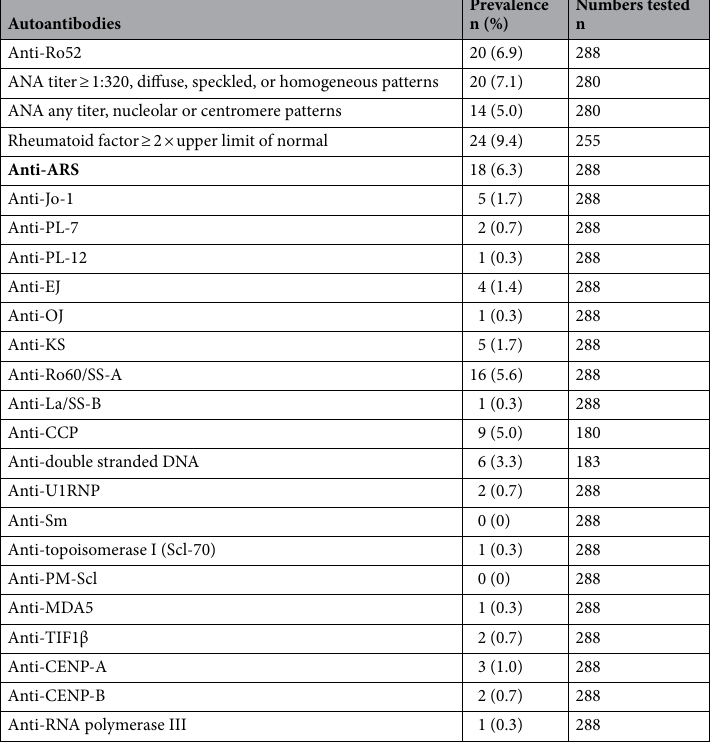
Table 1. Prevalence of autoantibodies in idiopathic interstitial pneumonitis (IIP) patients. Data presented as frequencies (%). Ro52: Ro52/tripartite motif-containing 21; ANA: anti-nuclear antibody; ARS: aminoacyl- tRNA synthetases; CCP: cyclic citrullinated peptide; MDA5: melanoma differentiation-associated gene 5; TIF1: transcriptional intermediary factor 1; CENP: centromere